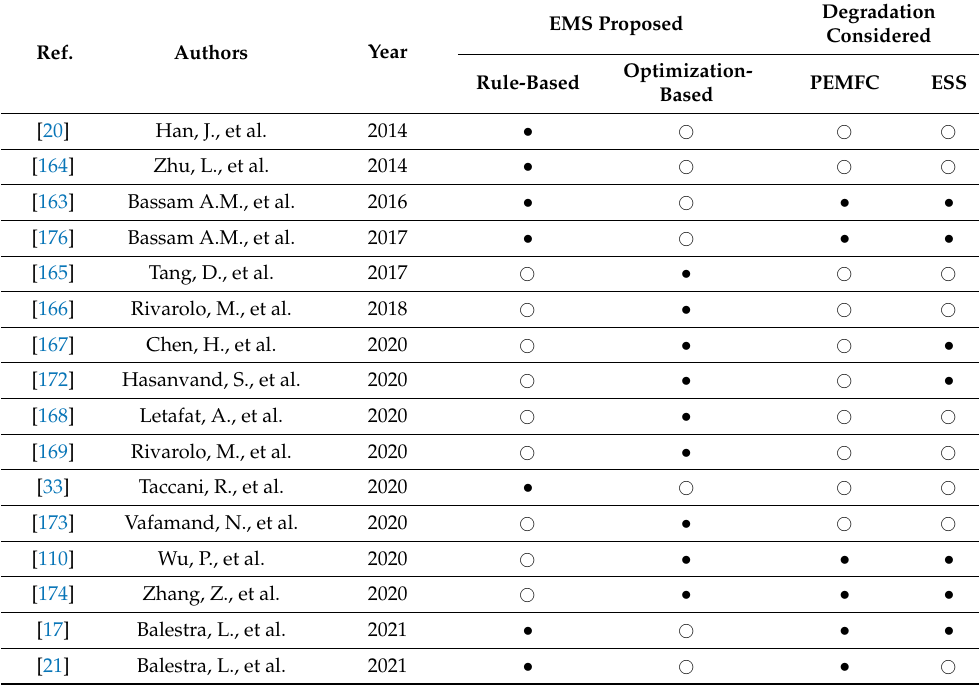
= not considered). (cid:35) Degradation EMS Proposed